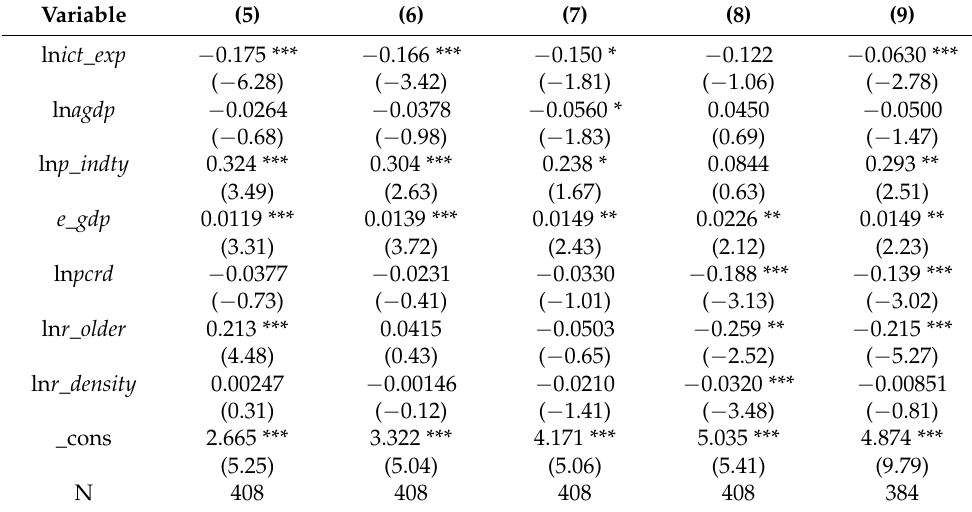
Table 5. The estimate result of the Sivqr